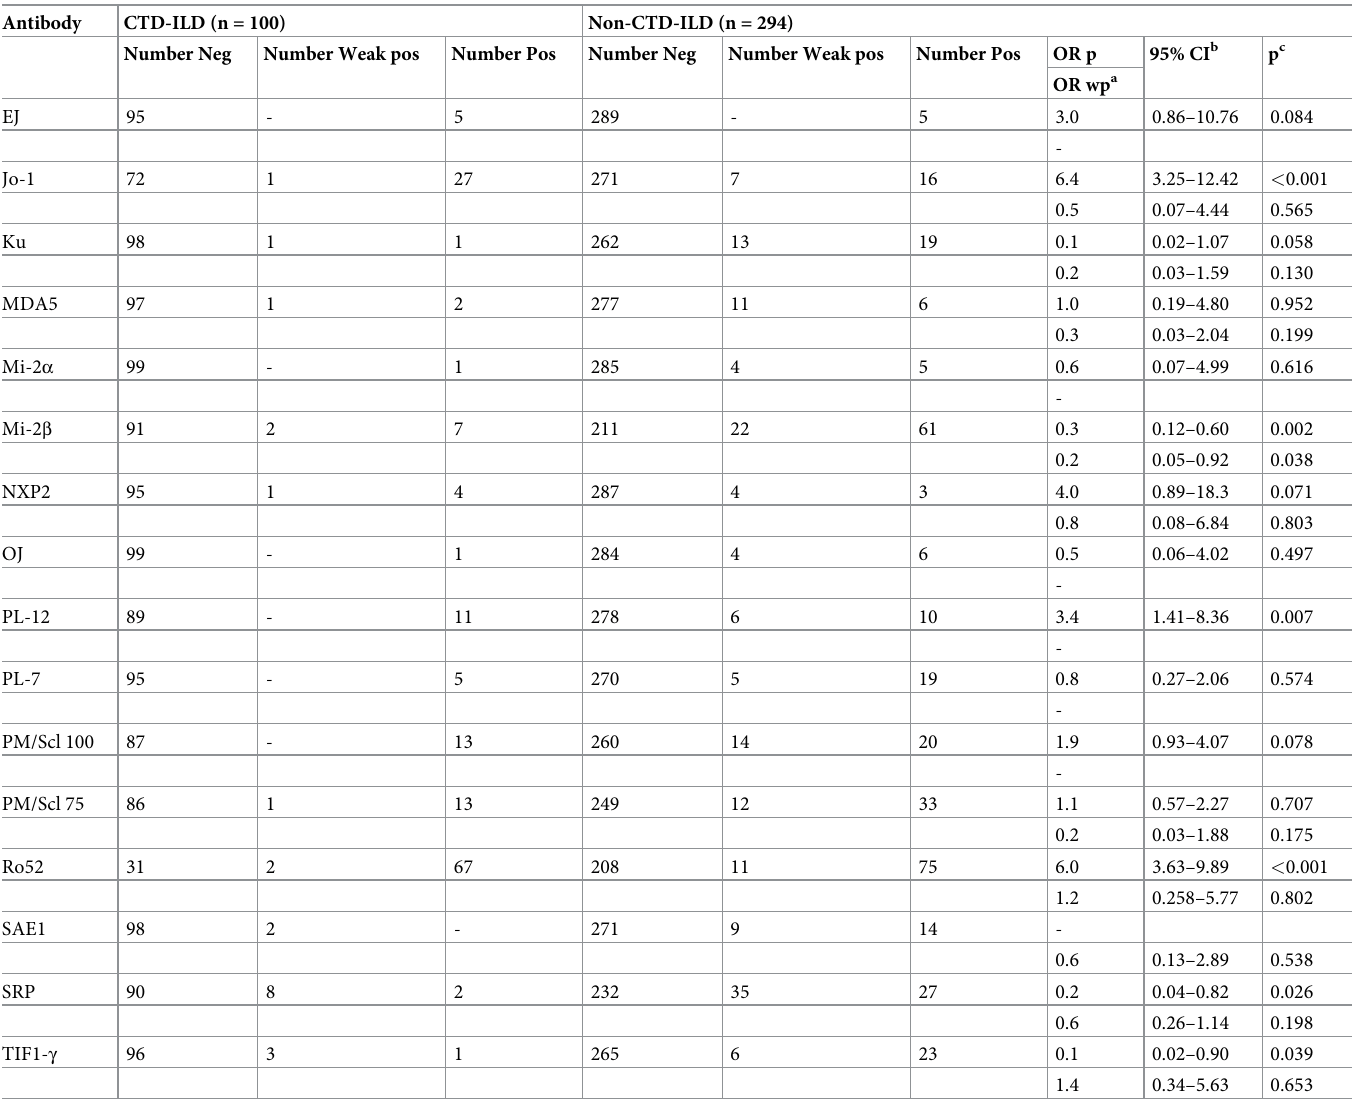
Table 3. Associations of myositis antibodies with ILD